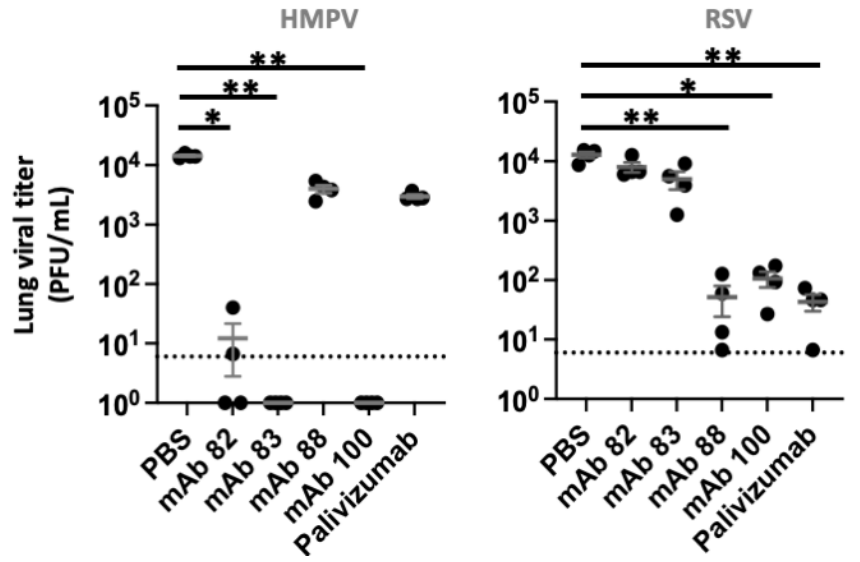
Figure 3. In vivo efficacy of selected mAbs against HMPV and HRSV. Female Mice were challenged with 5 × 10 5 TCID 50 of HMPV or 1 × 10 7 PFU of HRSV. Twenty four hours post-infection, mice received PBS or 250 μ g of mAb. On days 4 and 5 post- HRSV and HMPV infections, respectively, viral lung titers were assessed ( n = 4/group). *, ** indicates a statistically significant difference ( p <0.05, <0.01). Mean+/-SEM are shown.